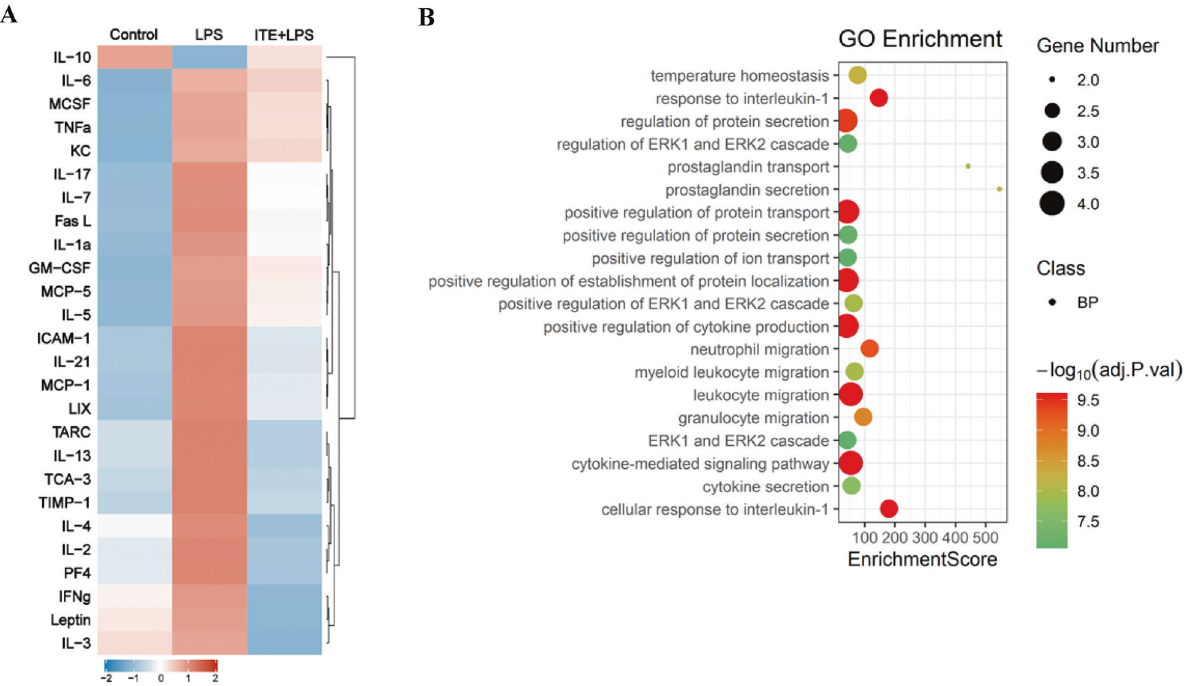
Fig. 6 ITE extensively inhibited secretion of LPS induced in fl ammatory cytokines in BV2 microglia. A RayBio mouse in fl ammatory cytokine antibody array was applied to detect in fl ammatory cytokine signatures in BV2 microglia cell conditioned medium of three groups. Control, unconditioned BV2-CCM; LPS, LPS induced BV2-CCM; ITE + LPS, ITE + LPS induced BV2-CCM. In fl ammatory cytokines were signi fi cantly reduced with ITE pre-administration. B GO biological process analysis of the top 20 processes involved in ITE + LPS vs LPS group. n = 3 in control group, n = 4 in LPS and ITE + LPS